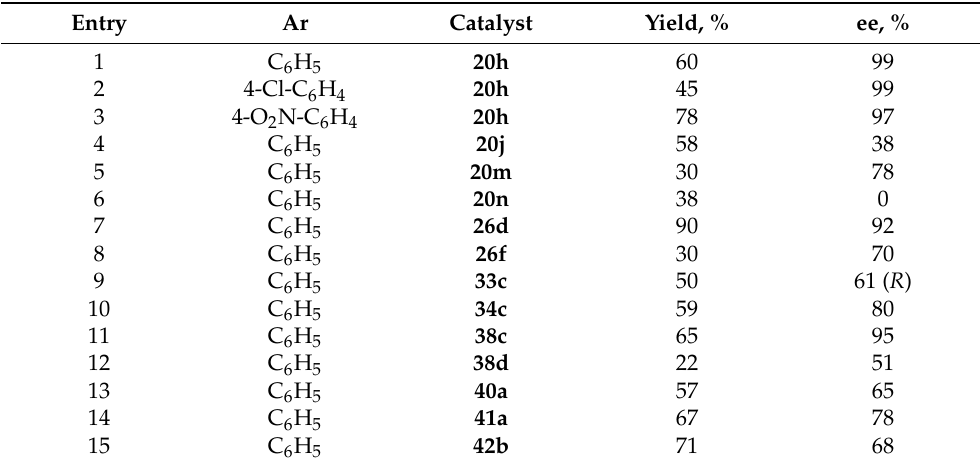
Table 4. Effect of crown ethers in the Michael addition of diethyl acetamidomalonate ( 59 ) to ni- trostyrenes ( 58 ).